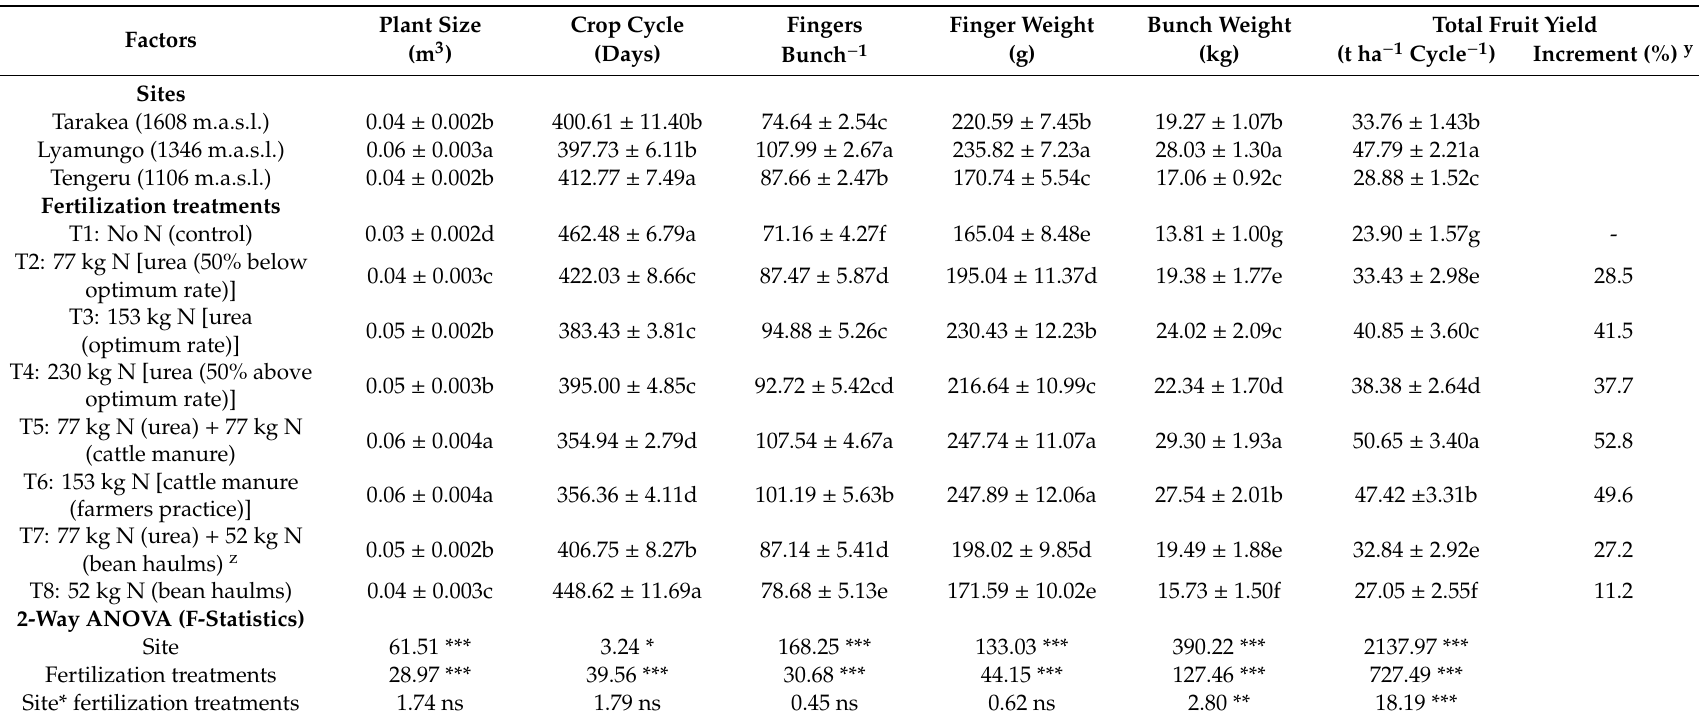
Table 4. E ff ects of fertilization treatments on the growth and yield of Mchare banana at the three sites located along the altitudinal gradients in volcanic soils of the northern highlands,